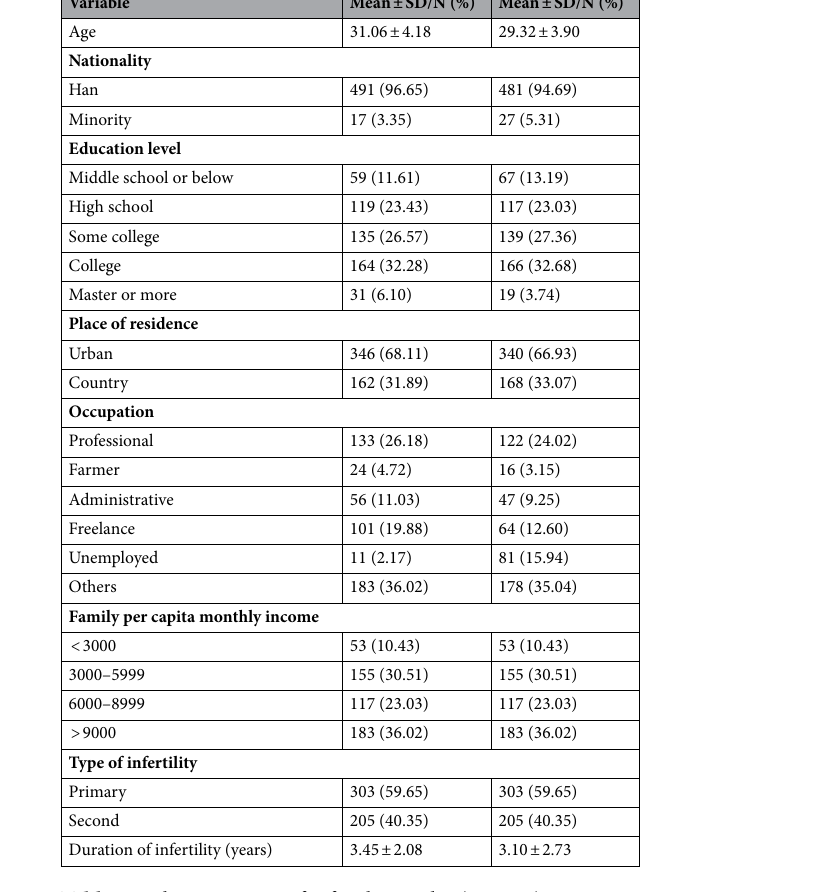
Table 1. Characteristics of infertile couples (N =